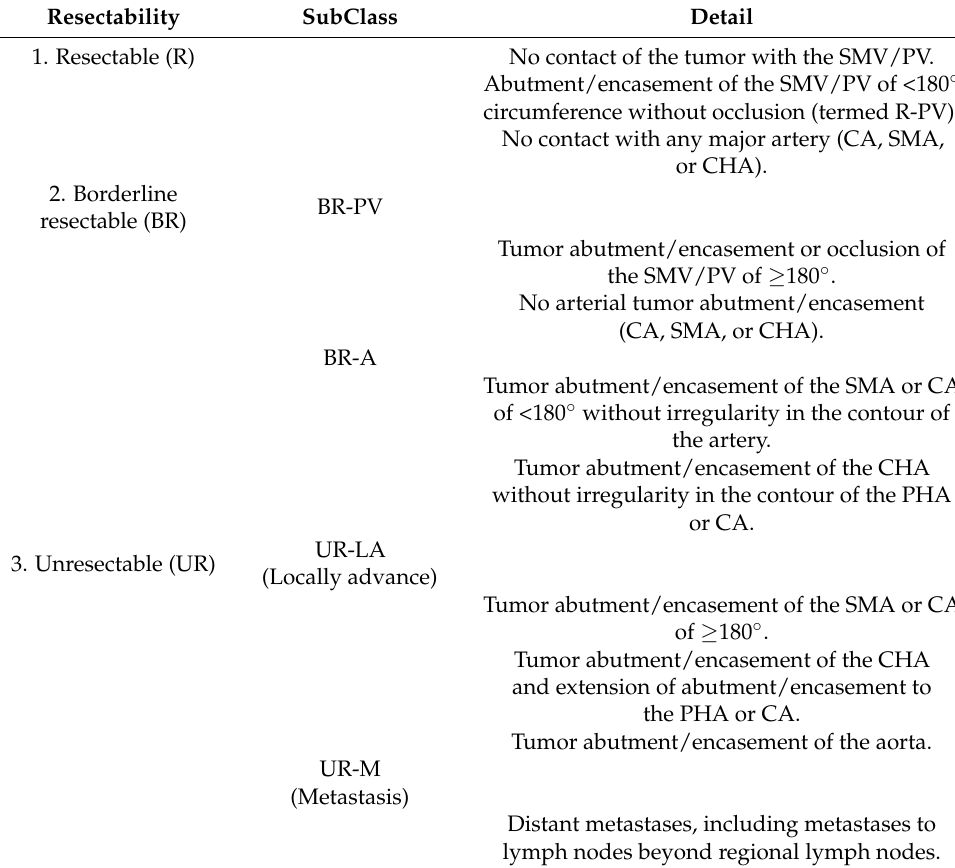
Table 6. Resectability criteria proposed by the